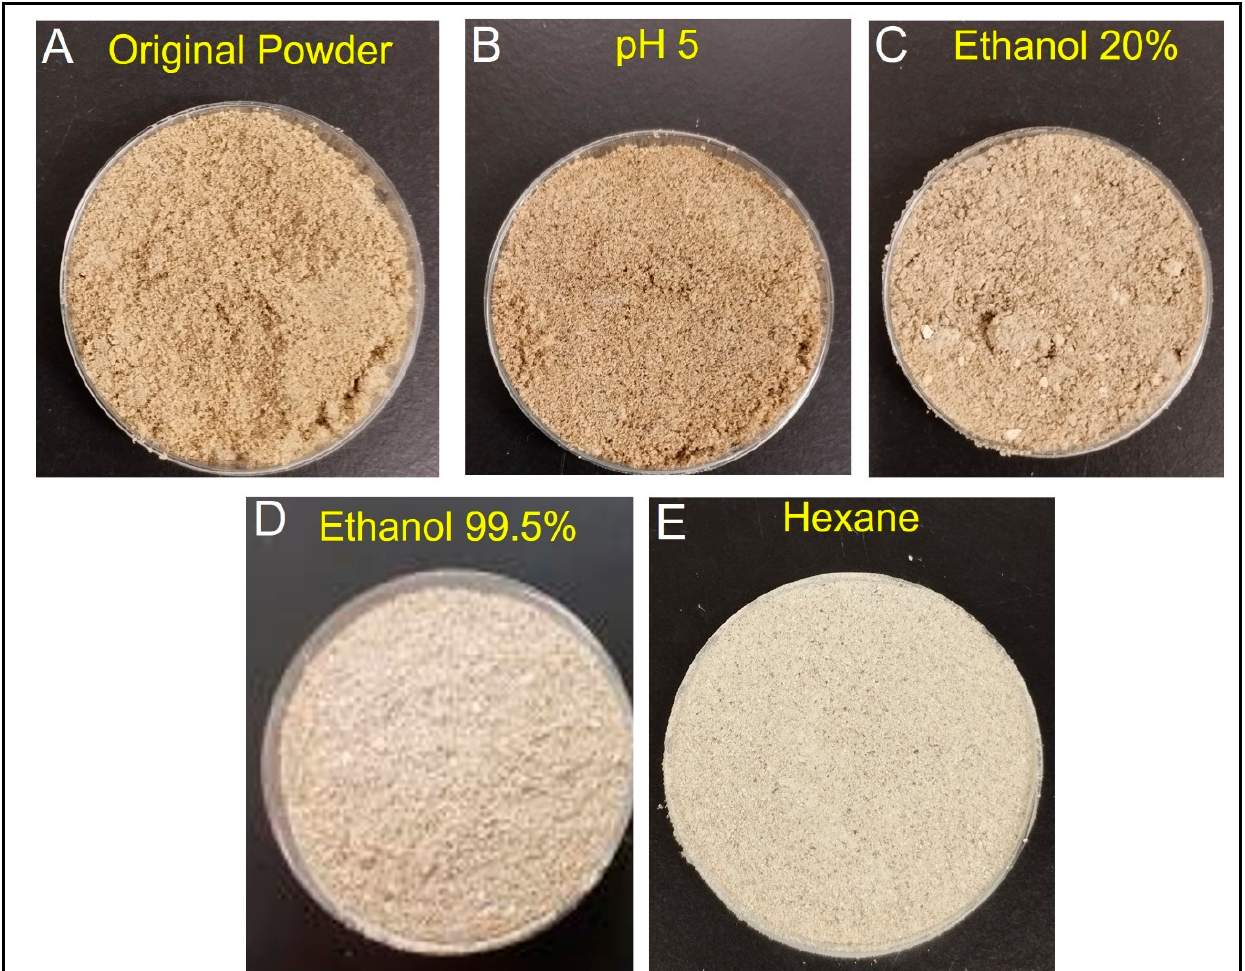
Figure 4. Pictures of the original powder and treated powders. ( A ) = original powder, ( B ) = pH 5 treated powder, ( C ) = ethanol 20% treated powder, ( D ) = ethanol 99.5% treated powder, ( E ) = hexane treated powder.